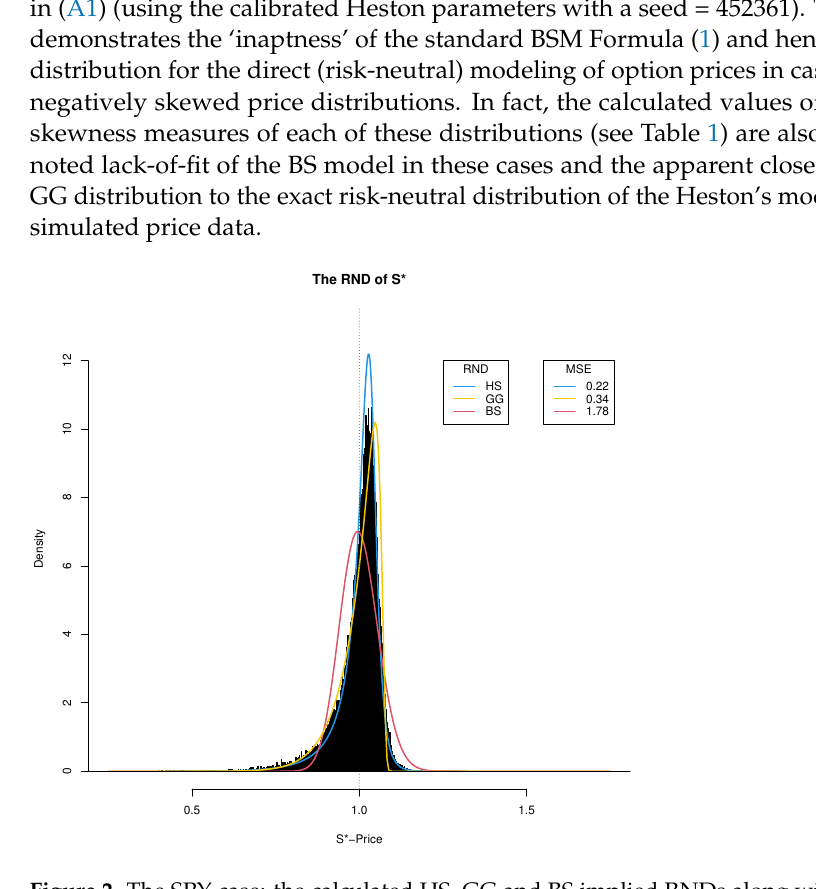
Figure 2. The SPY case: the calculated HS, GG and BS implied RNDs along with the Monte Carlo distribution of the spot’s price S ∗ and the corresponding values of the